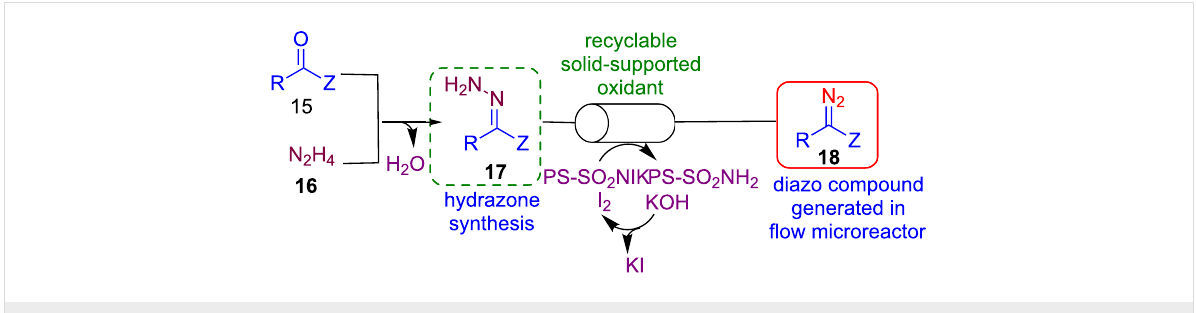
Scheme 16: Flow oxidation of hydrazones to diazo